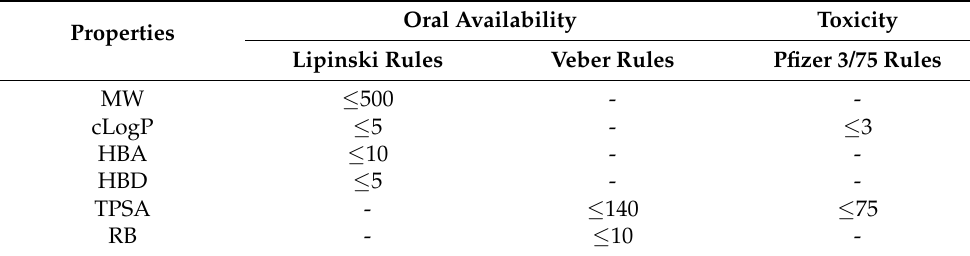
Table 5. Empirical rules for predicting the oral availability and toxicity properties of the studied lig-